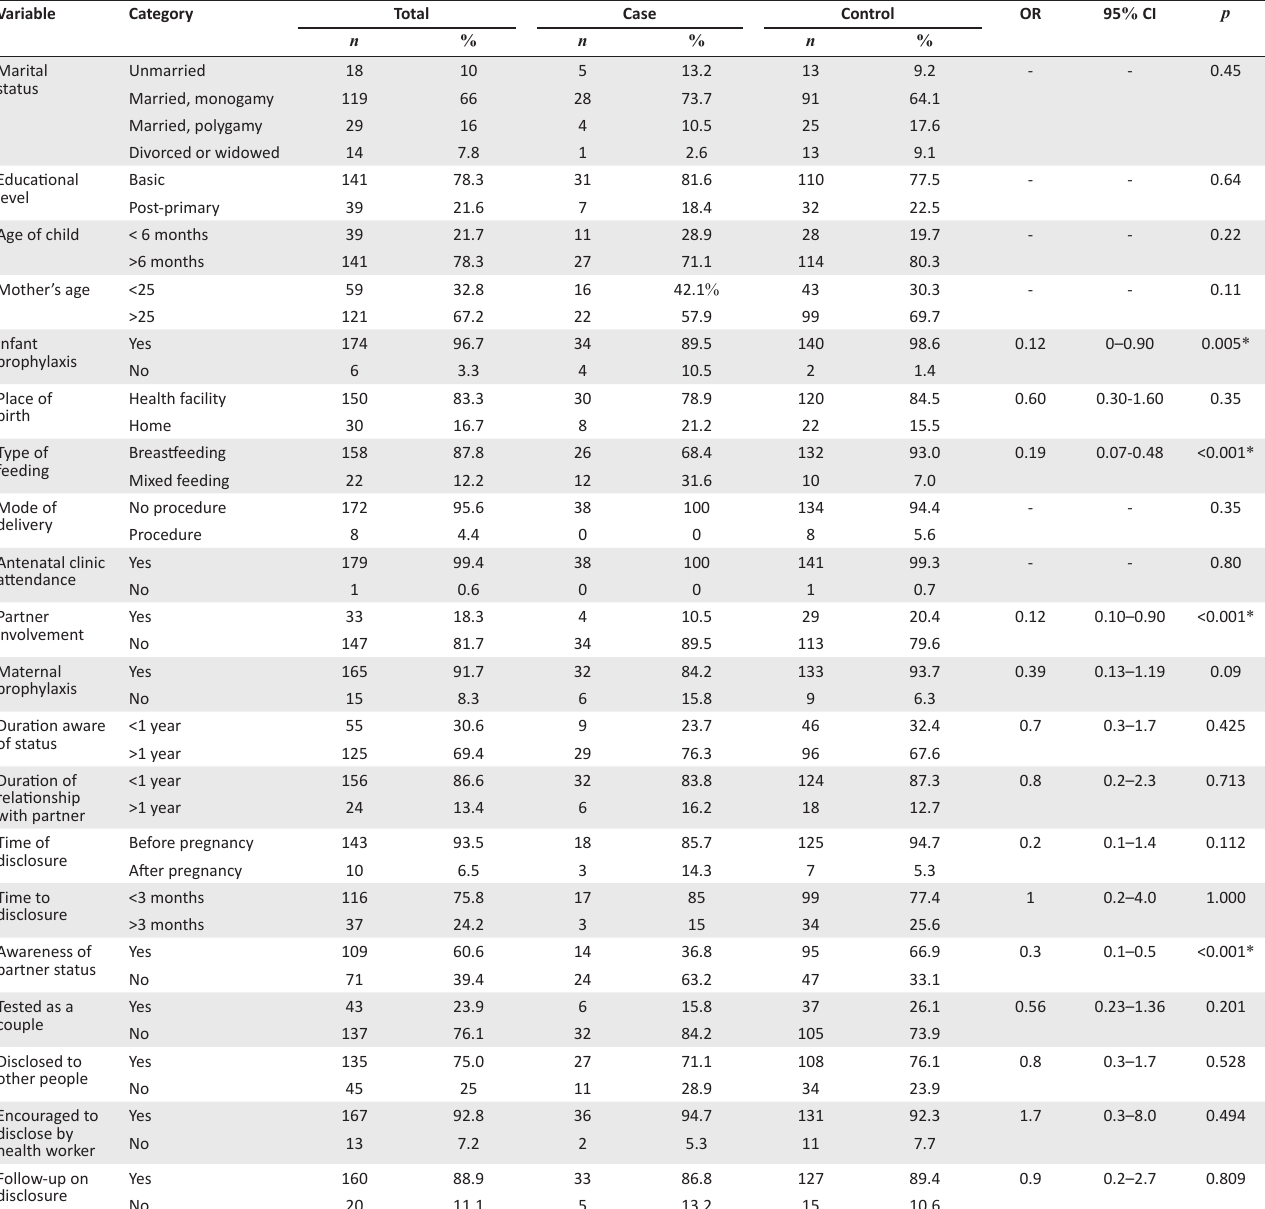
TABLE 2: Comparison of variables between cases and controls. Variable Category